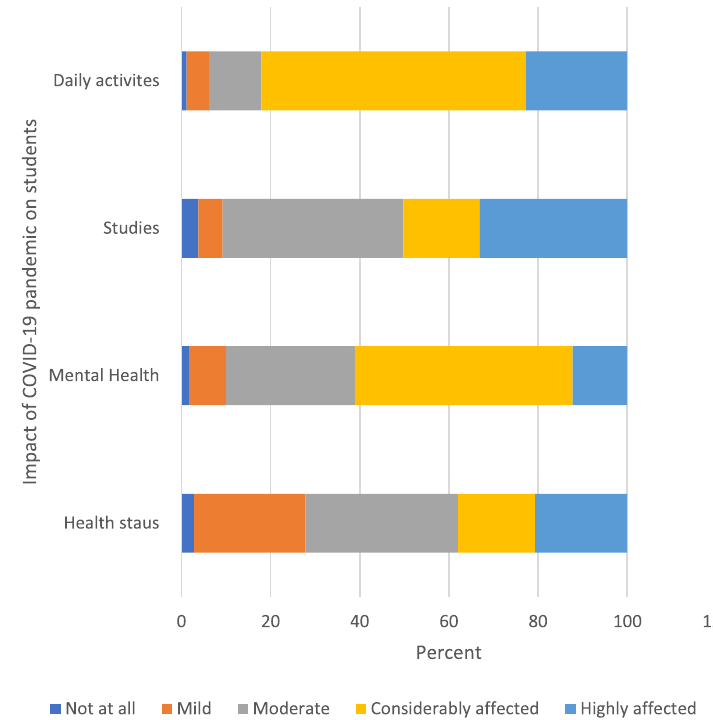
Fig. 1 Impact of COVID-19 pandemic on students’ health and quality of